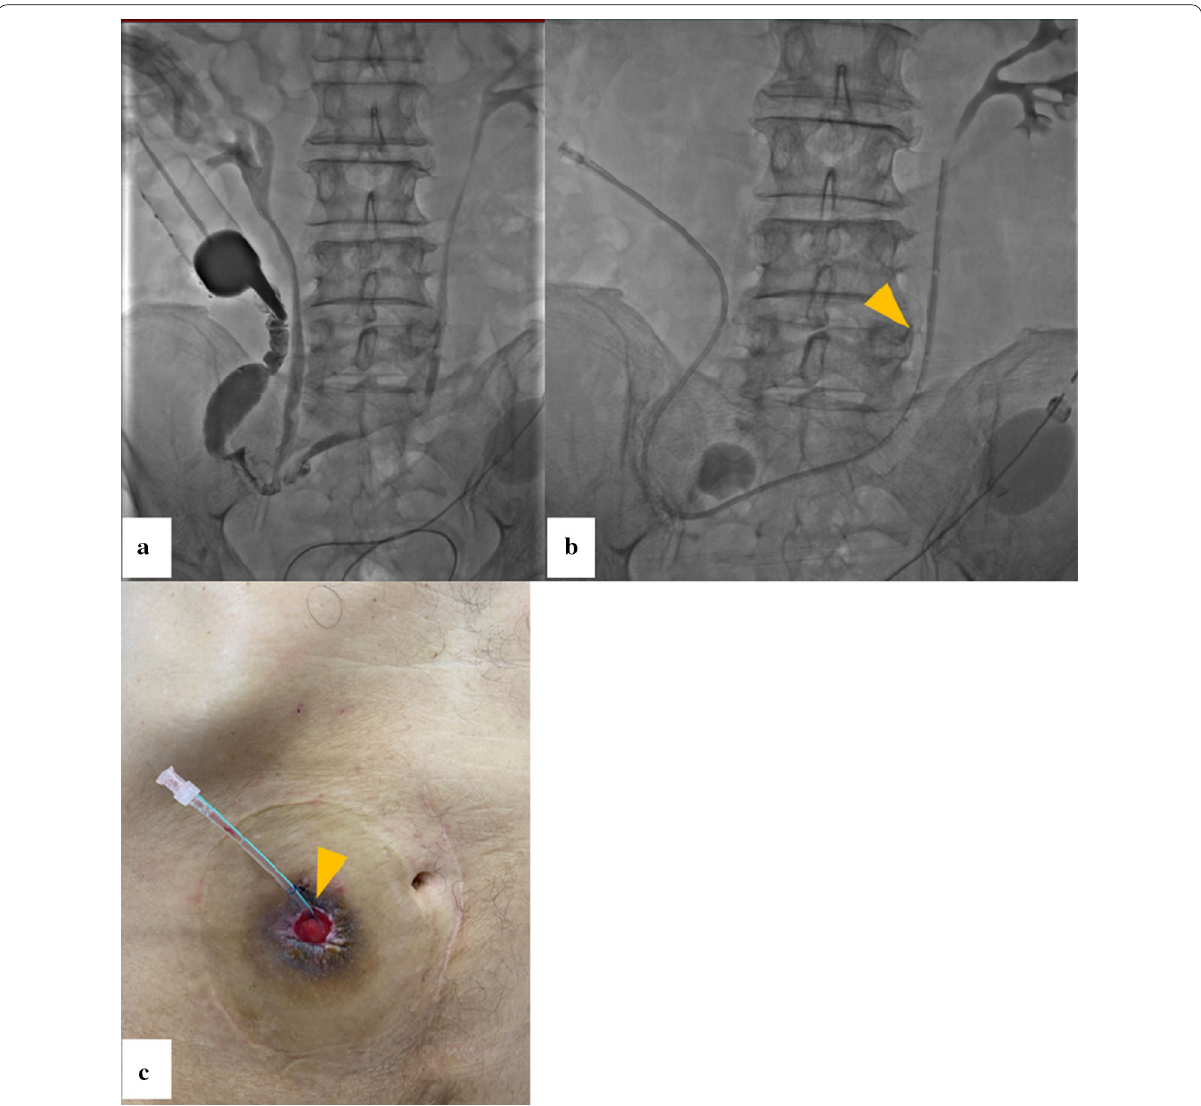
Fig. 2 Procedure of retrograde transileal conduit ureteral catheter placement. a Contrast medium is injected to provide a road map of the ileal conduit to reflux up the ureters. b A 10 Fr catheter with multiple side holes is inserted in the left ureter (arrowhead). c A catheter is fixed to the skin near the ileal conduit using 3-0 nylon to prevent deviation due to ureteral peristalsis